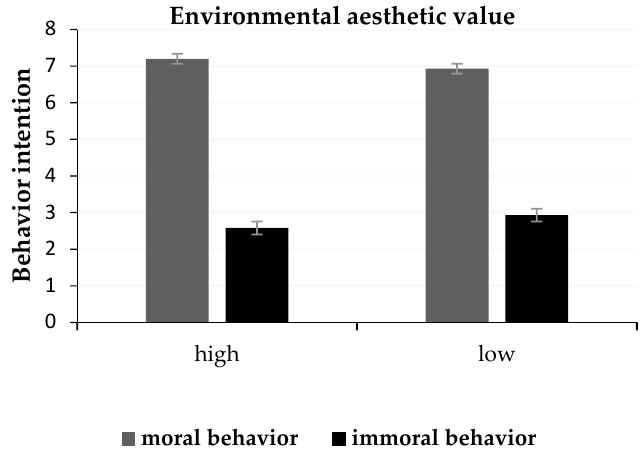
Figure 5. The scores of behavioral intentions in different environments.